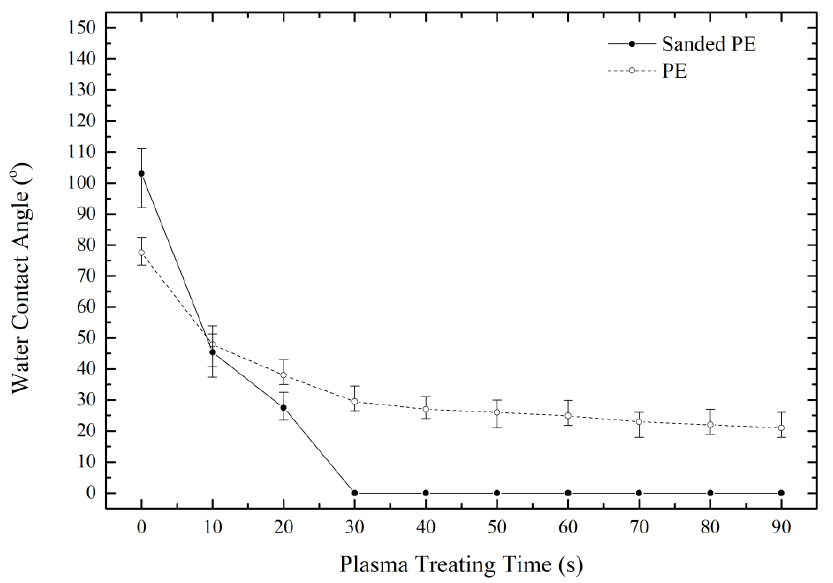
Figure 10. WCAs of PE films after various plasma treating times.